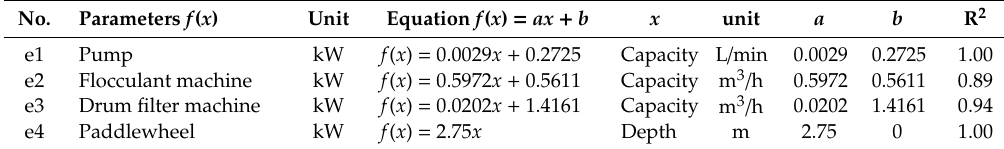
Table A2. Function list of “electricity” for dependent parameters. ( x is derived from Table A1) . No.